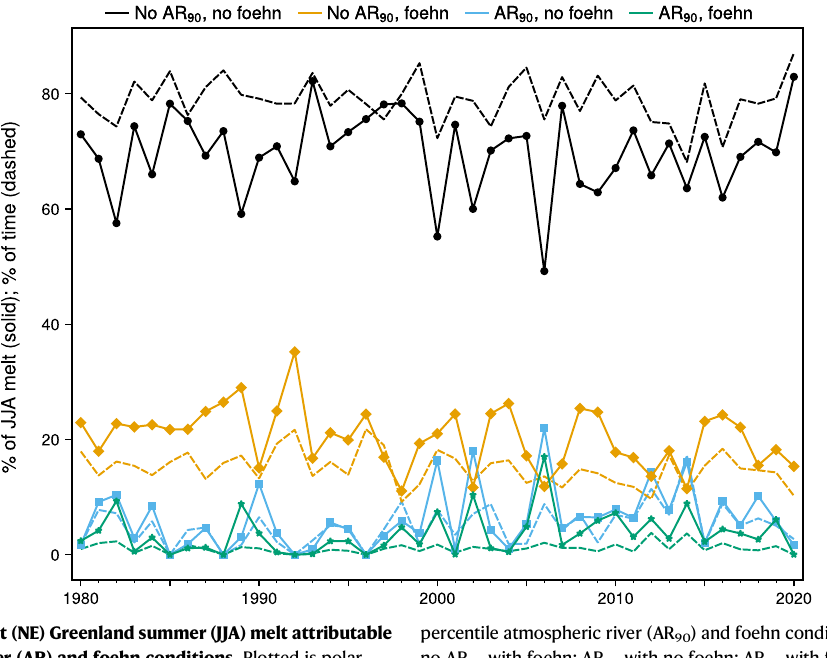
percentile atmospheric river (AR 90 ) and foehn conditions: no AR 90 with no foehn; no AR 90 with foehn; AR 90 with no foehn; AR 90 with foehn. Also plotted is the percentage of time during each JJA season classi fi ed into each category (dashed